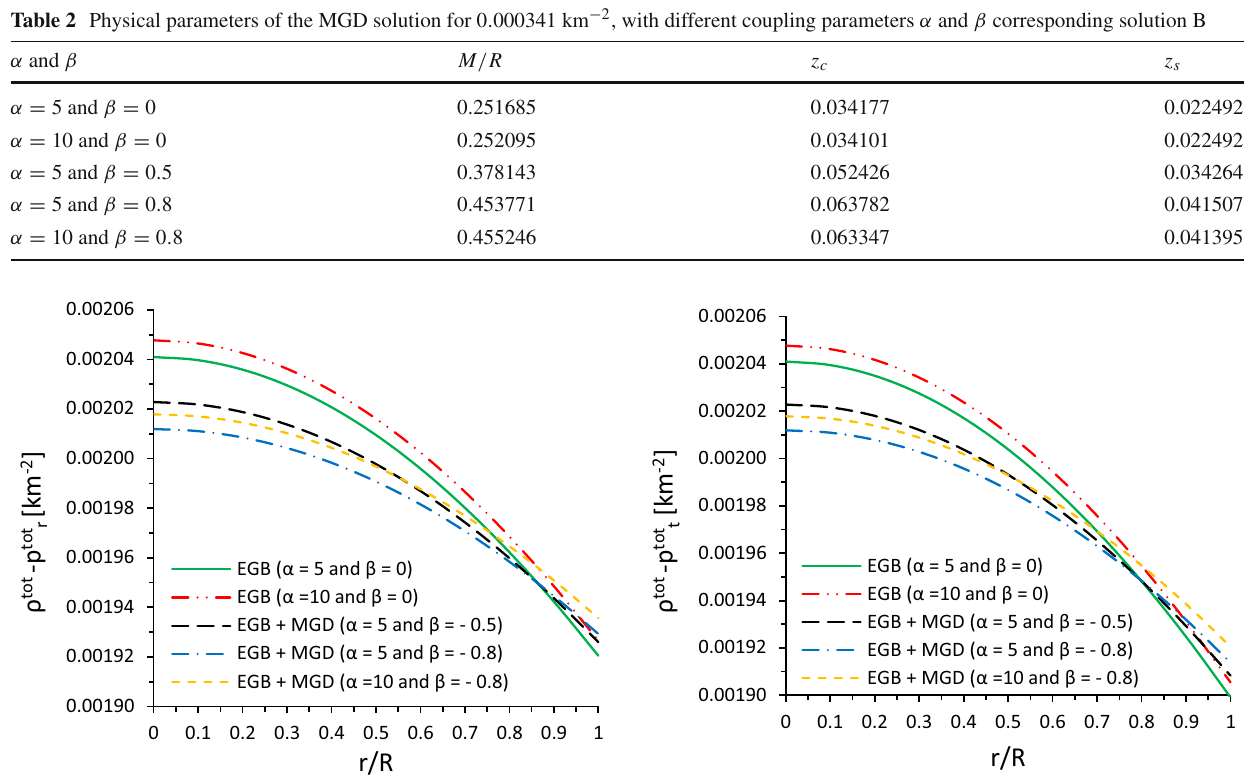
Fig. 7 The variation of dominant energy conditions versus radial coordinate r / R for solution